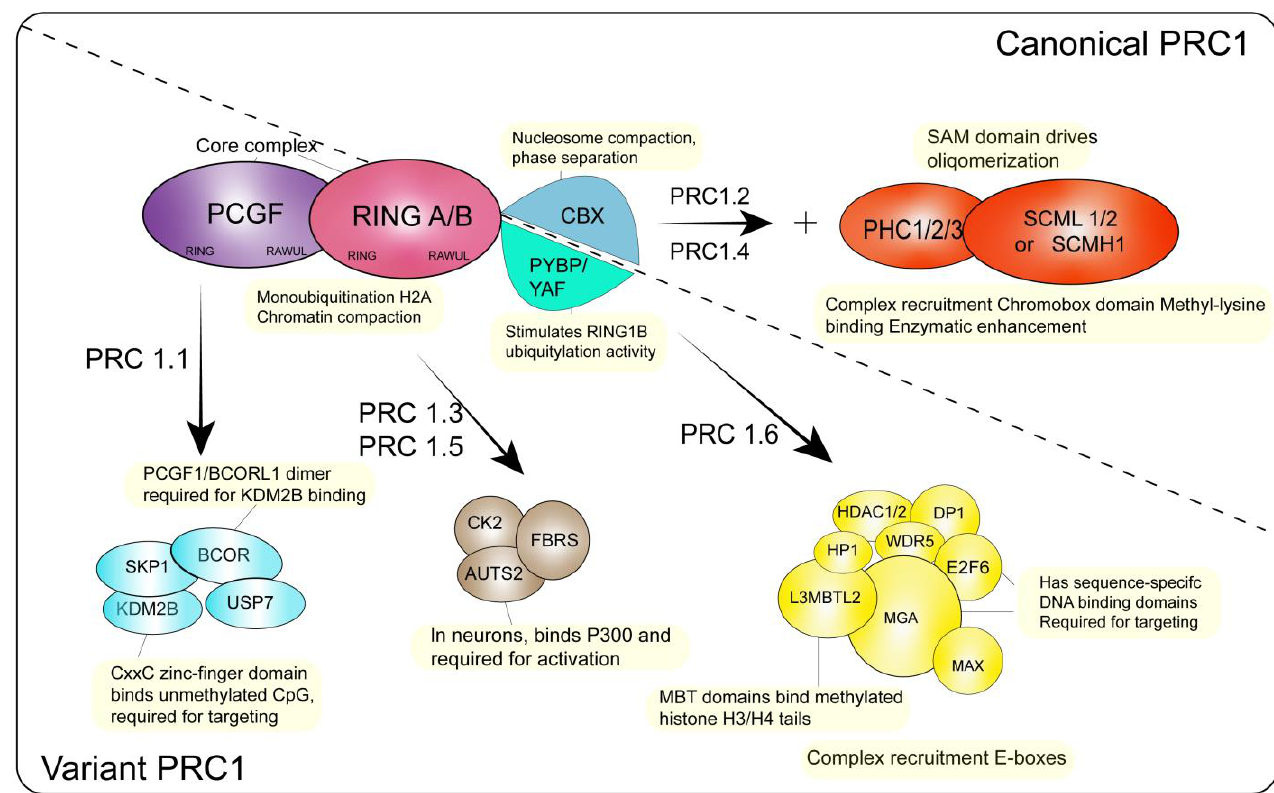
Figure 1. Comparisons of different groups of PRC1 complexes. Illustration of core and accessory subunits composing canonical and variant PRC1